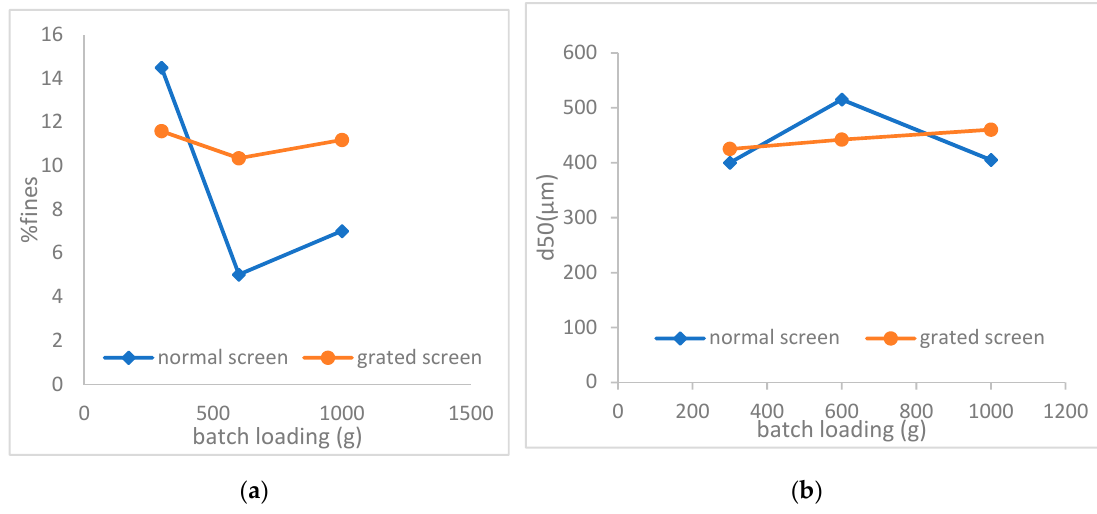
Figure 9. Plot showing the effect of batch loading on %fines ( a ) and on d50 ( b ) for grated and normal screen.